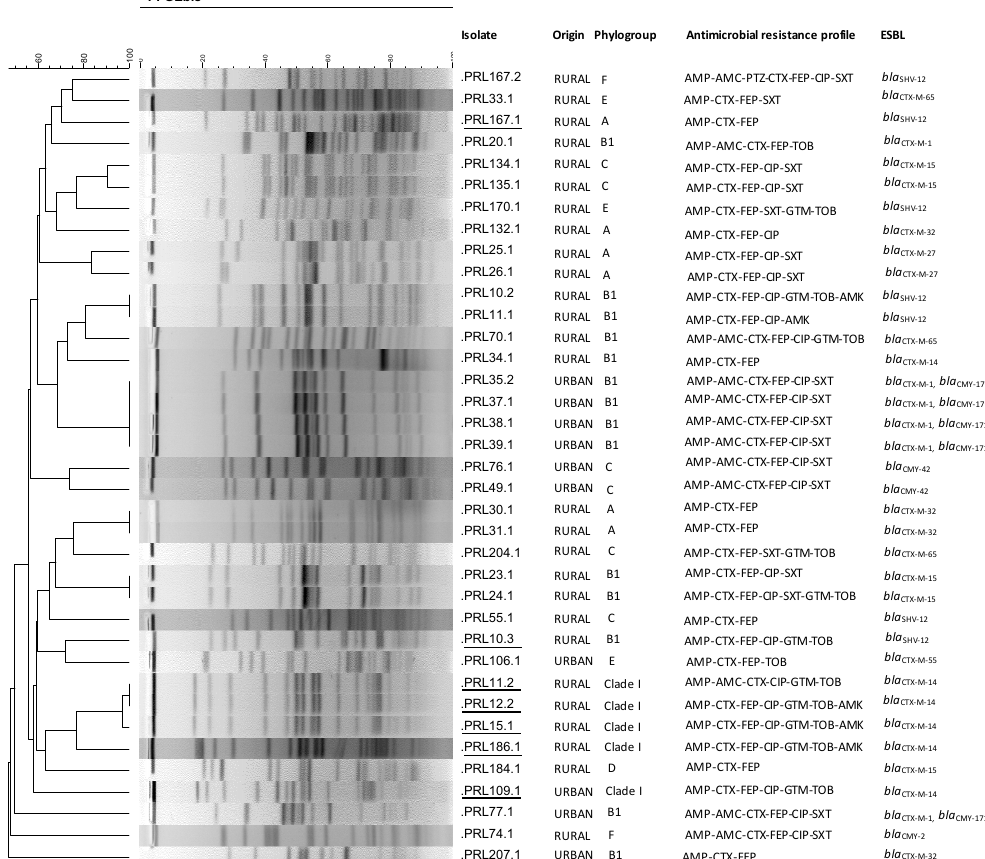
Figure 1. Dendrogram of genomic similarity obtained by XbaI-PFGE typing of ESBL-producing Escherichia coli isolates from rural and urban dogs in Northwest Spain. Isolate numeration was done by using the correlative number of the dog studied, followed by a dot and a second number if the same dog has more than one positive isolate. AMP, ampicillin; AMC, amoxicillin/clavulanic acid; PTZ, piperacillin/tazobactam; CTX, cefotaxime; FEP, cefepime; CIP, ciprofloxacin; SXT, trimethoprim/sulphamethoxazole; GTN, gentamicin; TOB, tobramycin; AMK, amikacin. Isolates